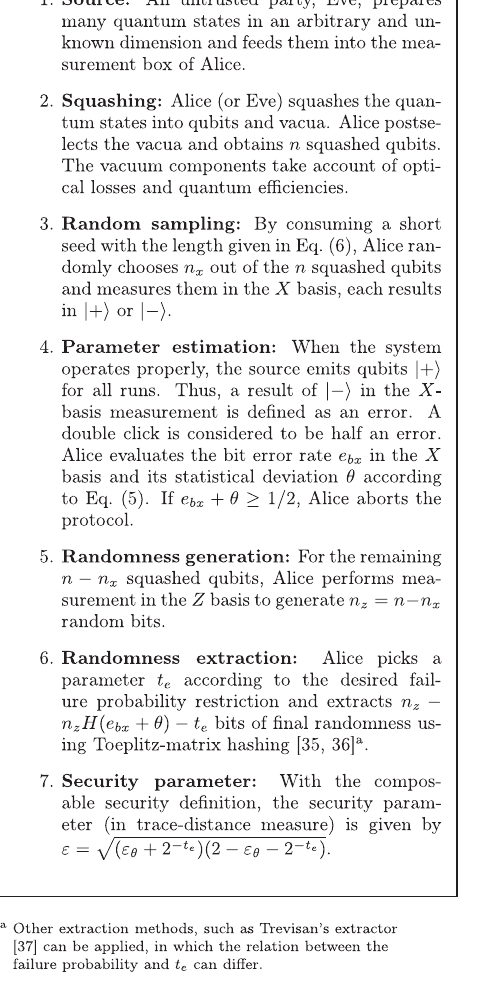
FIG. 3. Source-independent QRNG with the finite-data-size effect. The results are proven in Sec.